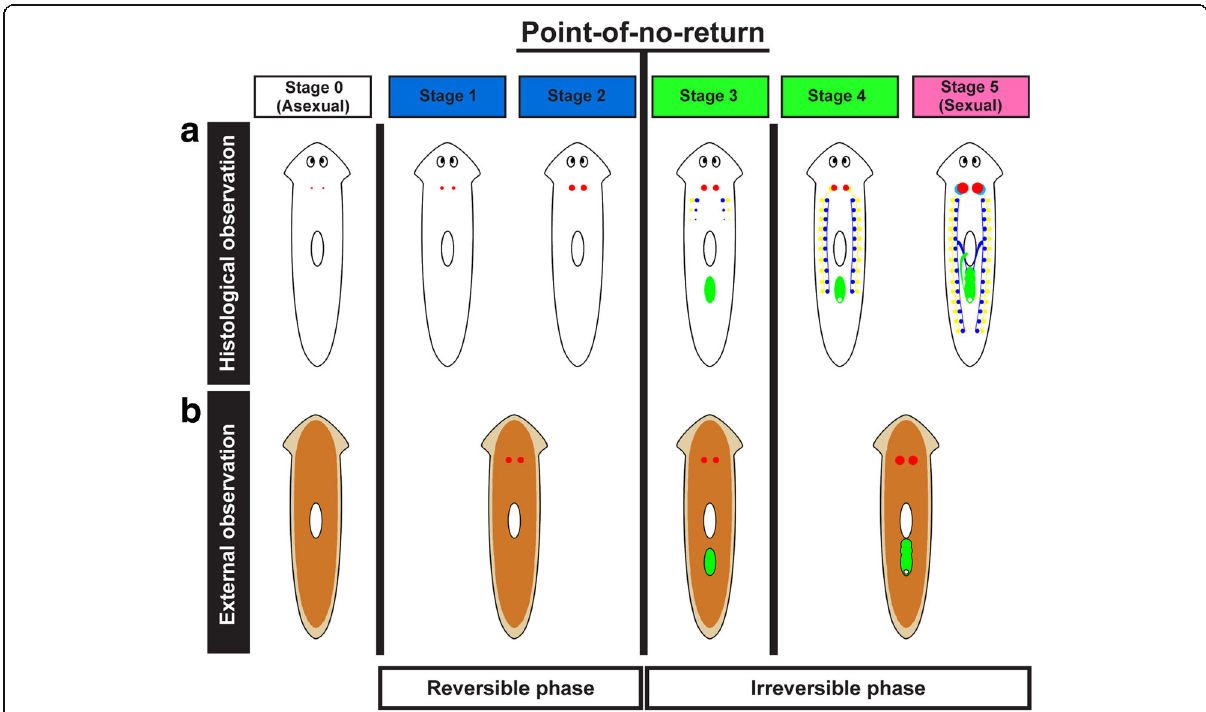
Fig. 3 Five stages of sexual induction and estimation of stages by external observation. a Morphological changes during sexual induction allowed us to divide the process into five stages. The colored regions correspond to the reproductive organs: red, ovary; aqua blue, seminal receptacle; blue, testis; yellow, yolk gland; green, copulatory apparatus. Cell masses of female primordial germ cells (primordial ovaries) were histologically identified in the asexual worms (stage 0), although they were barely visible externally. The ovaries became sufficiently large to be externally apparent behind the head, although no oocytes or other reproductive organs were detectable at stage 1. Oocytes appeared in the ovaries, but other reproductive organs remained undetectable at stage 2. The primordial testes and yolk gland primordia emerged, and a copulatory apparatus became visible in the post-pharyngeal region at stage 3. The genital pore in the copulatory apparatus opened on the ventral side of the worm and spermatocytes appeared in the testes at stage 4. Mature yolk glands formed, and spermatids and spermatozoa were detectable in the testes at stage 5. b By external observation of the test worms, we can recognize a pair of ovaries and a copulatory apparatus (without or with a genital pore) in the ventral side of test worms. The colored regions correspond to these reproductive organs: red, ovary; green, copulatory apparatus. Three stages were identified by external observation: worms with only a pair of ovaries (stage 1 – 2), worms with